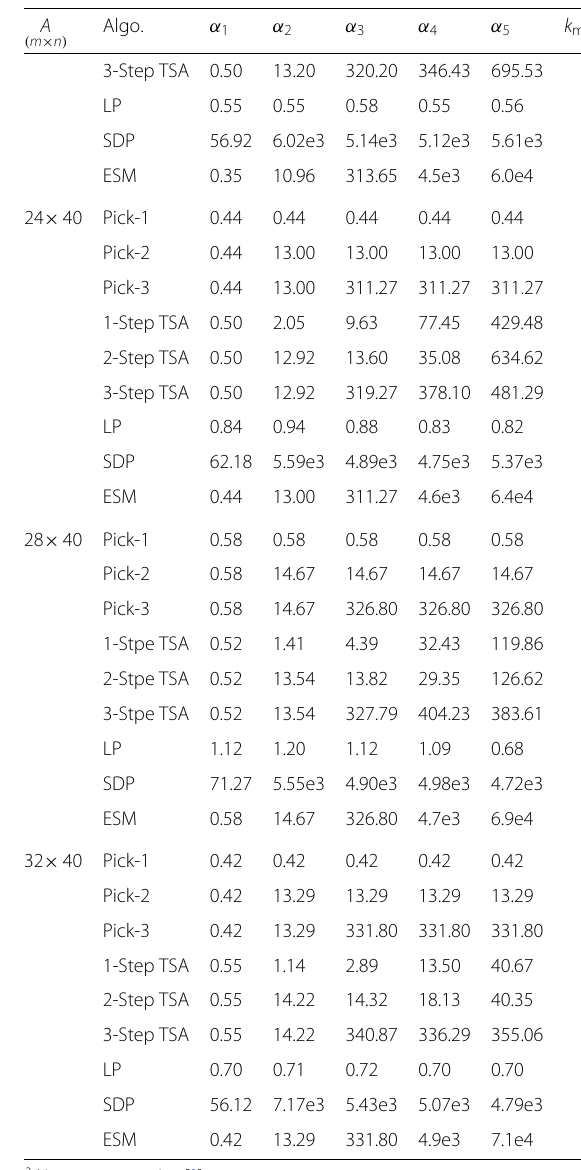
Table 7 α k comparison and execution time - Gaussian